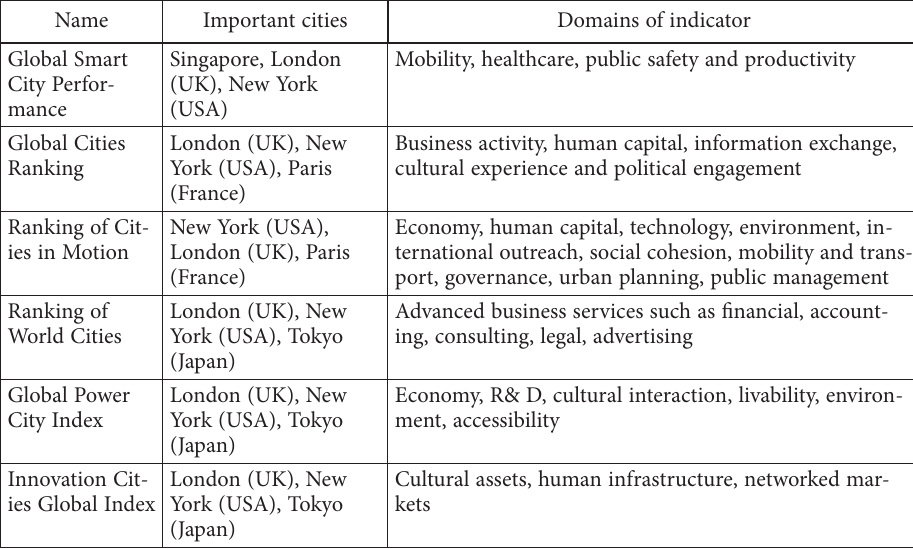
Table 1. Characteristic of the most popular ranking of smart cities Name